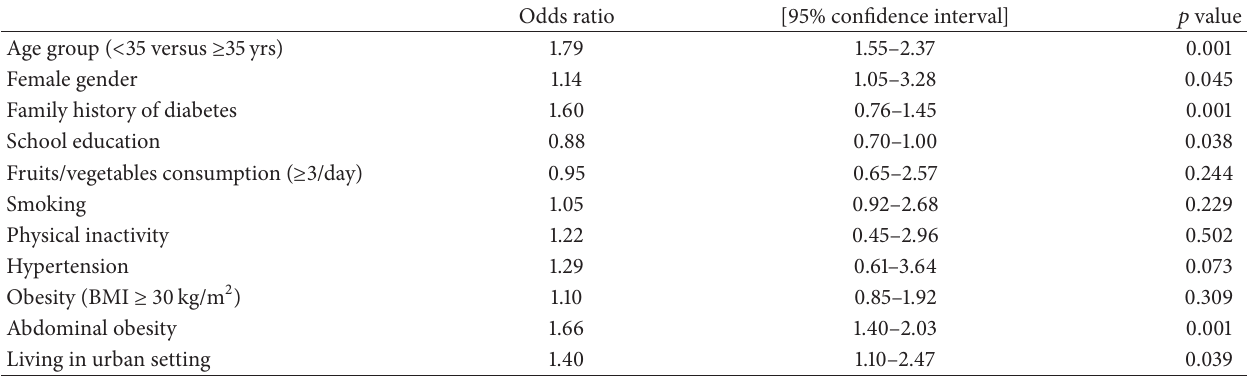
Table 2: Crude association between diabetes and risk factors (univariate analysis).